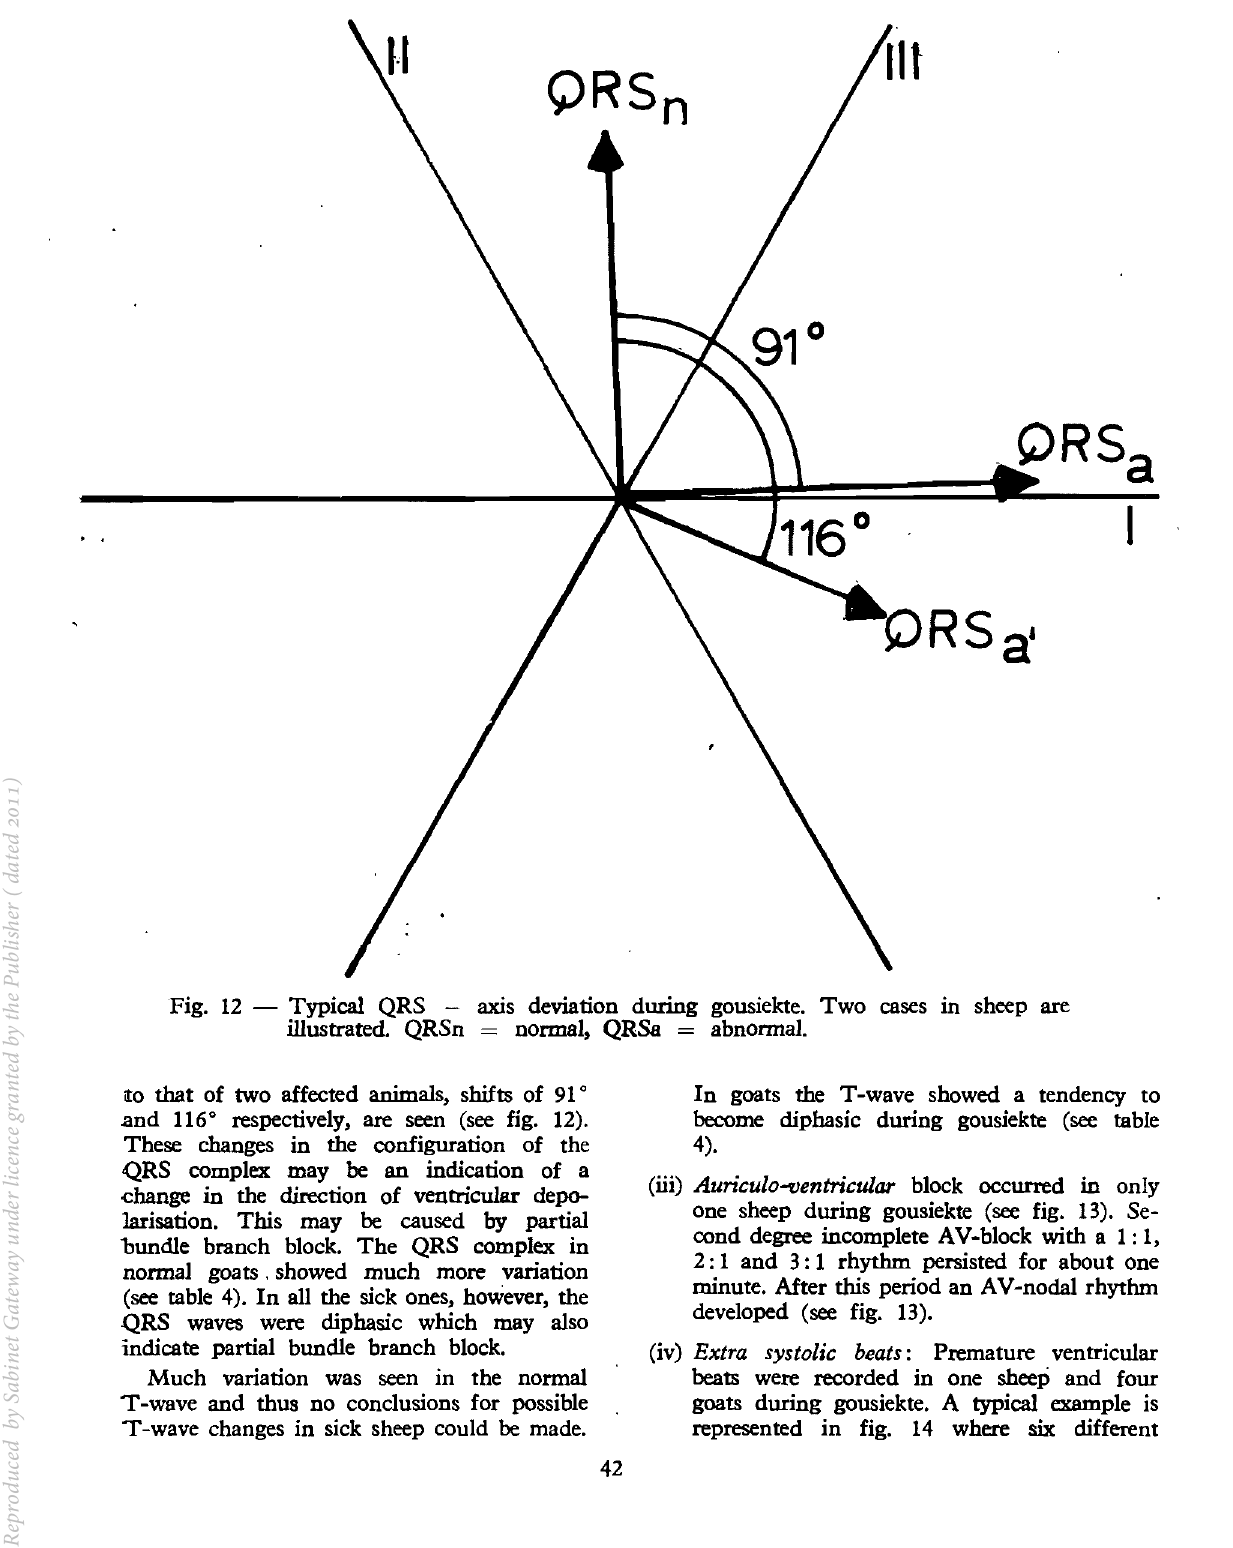
Fig. 12 - Typical QRS - axis deviation during gousiekte. Two cases in sheep are illustrated. QRSn = normal, QRSa = abnormal. itO that of two affected animals, shifts of 91 Q .and 116° respectively, are seen (see fig. 12). These changes in the configuration of the QRS complex may be an indication of a -change in the direction of ventricular depo larisation. This may be caused by partial bundle branch block. The QRS complex in normal goats. showed much more variation (see table 4). In all the sick ones, however, the QRS waves were diphasic which may also indicate partial bundle branch block. Much variation was seen in the normal T -wave and thus no conclusions for possible T -wave changes in sick sheep could be